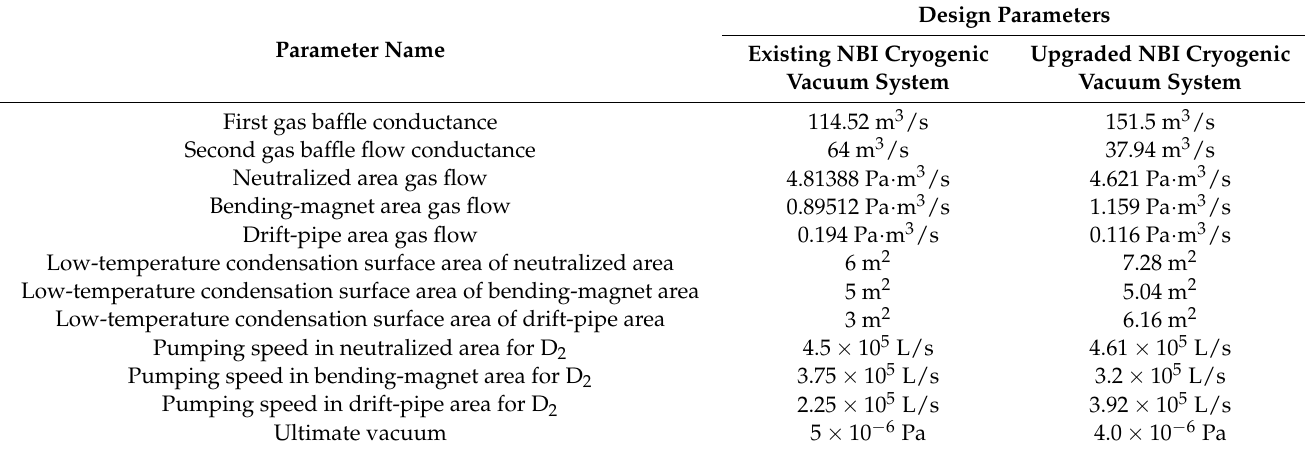
Table 2. NBI vacuum system parameters before and after